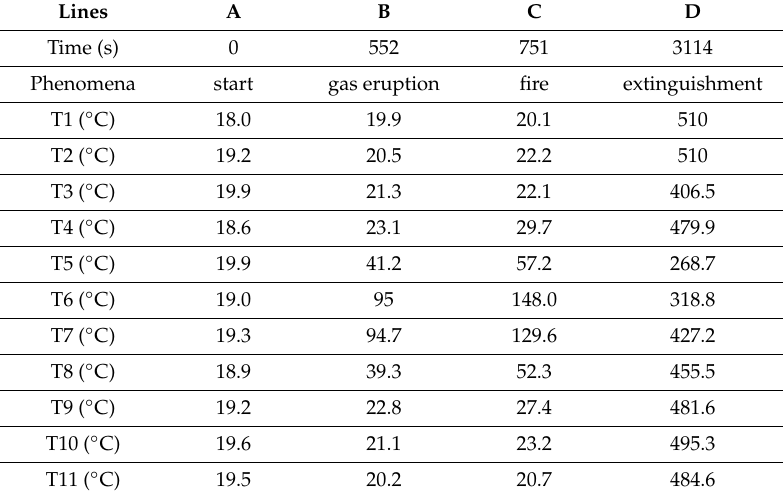
Figure 6. Pole temperature responses. Table 2. Temperature data in Figure